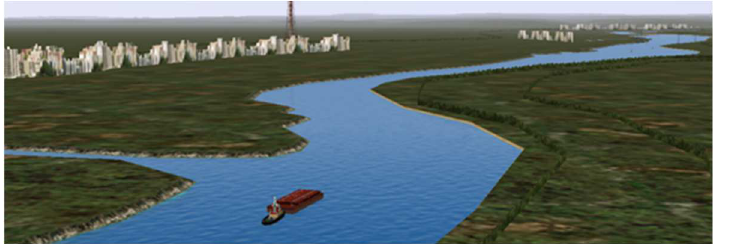
Figure 7. A pusher and a barge on the assigned route from the second task during the simulation attempt. Source: Navi-Trainer Professional 5000.